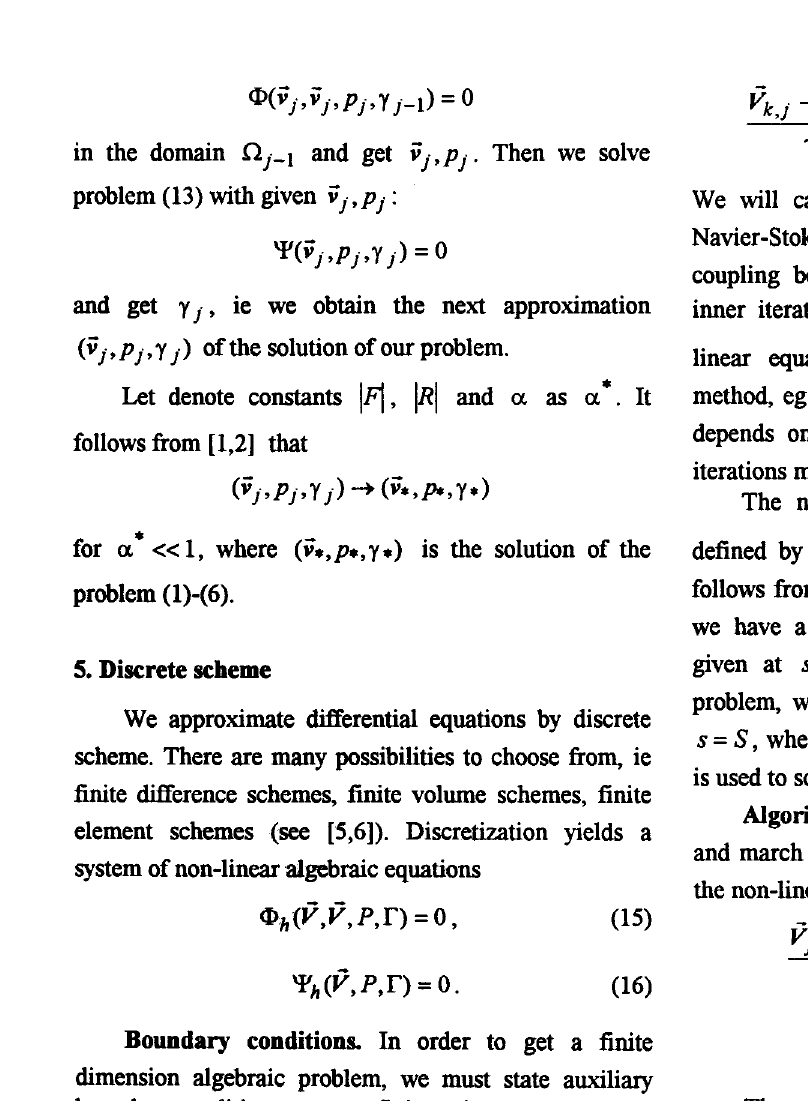
Algorithm 2. We modify the previous algorithm